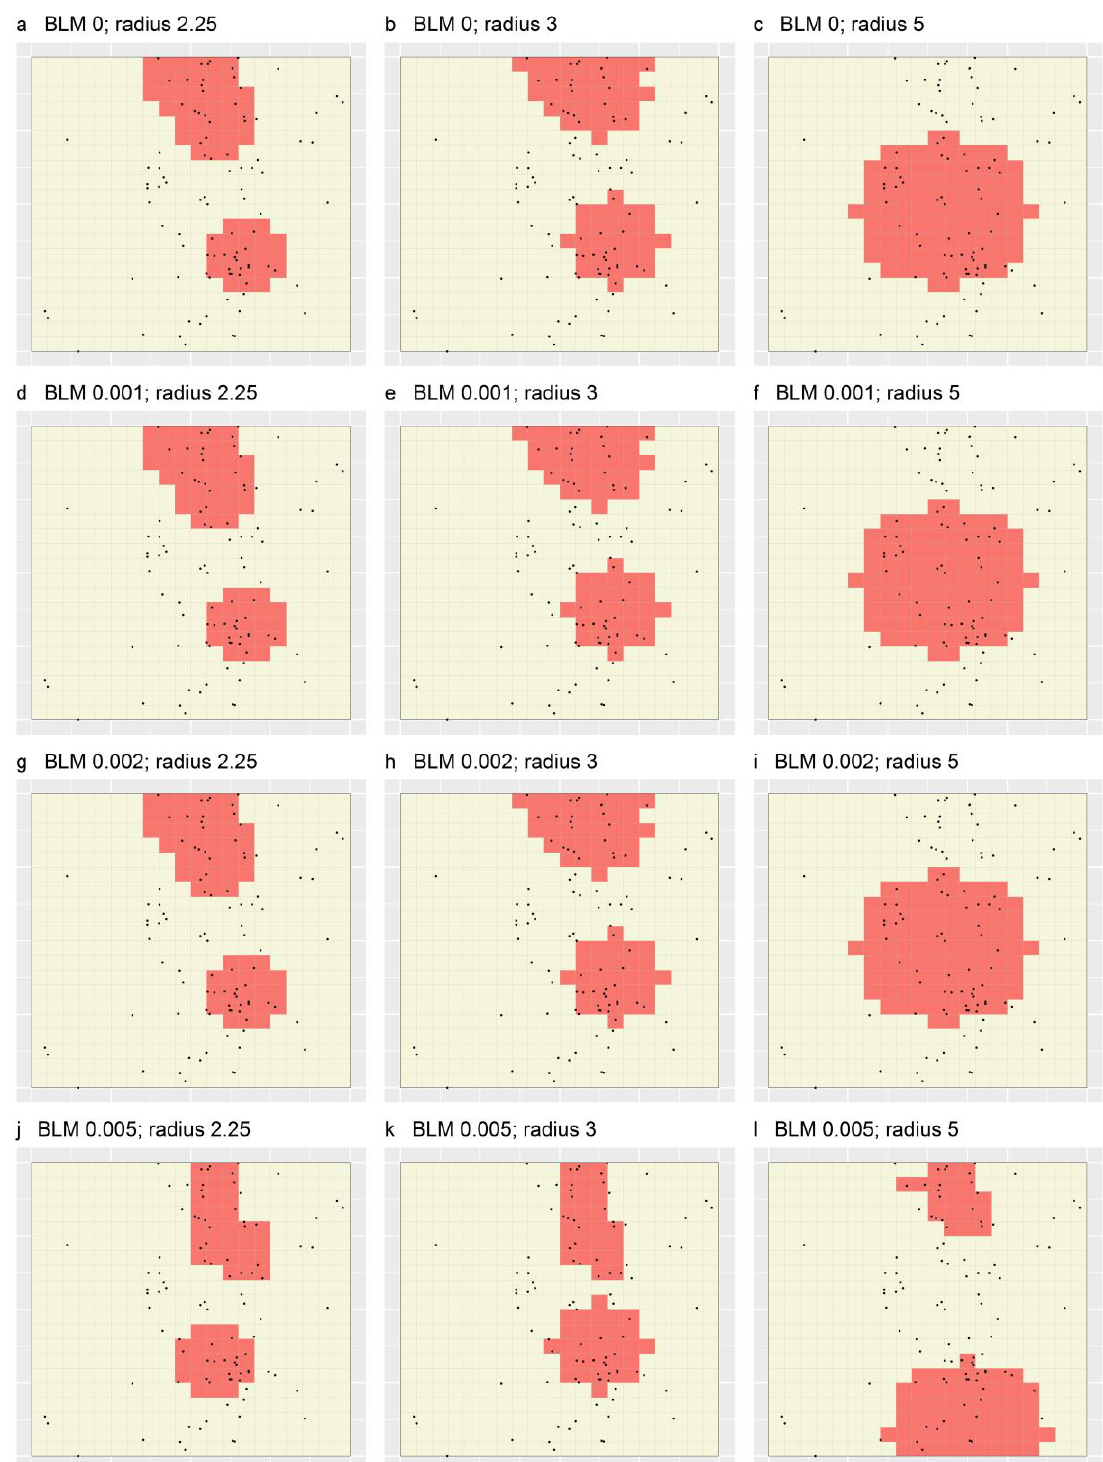
Figure 6. Optimal portfolios produced through applying Marxan + MinPatch to a simulated dataset based on 12 combinations of BLM and radius, and no simulated whittling. Black dots depict the locations of simulated cases, and grid lines represent the set of spatial planning units specified for Marxan + MinPatch. In each panel, shaded regions comprise ≥ 50% of